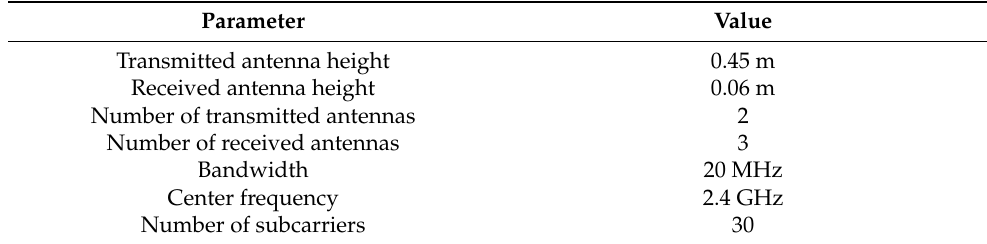
Table 1. System configuration of measurements.